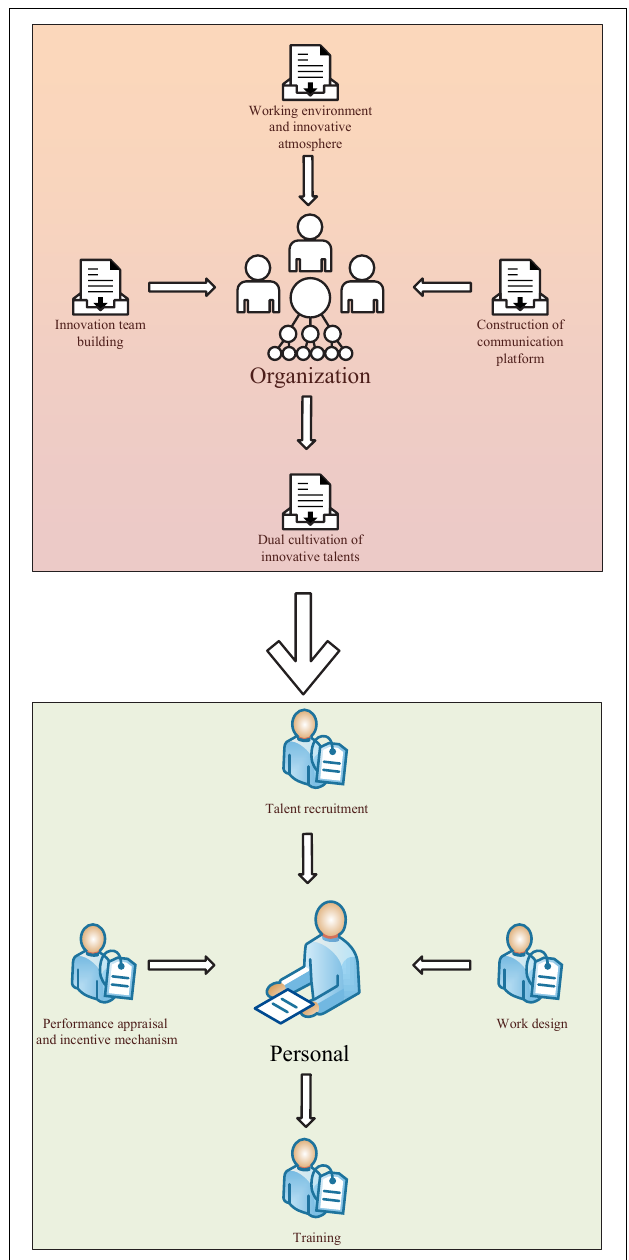
FIGURE 9 | The practical framework for training innovative talents.